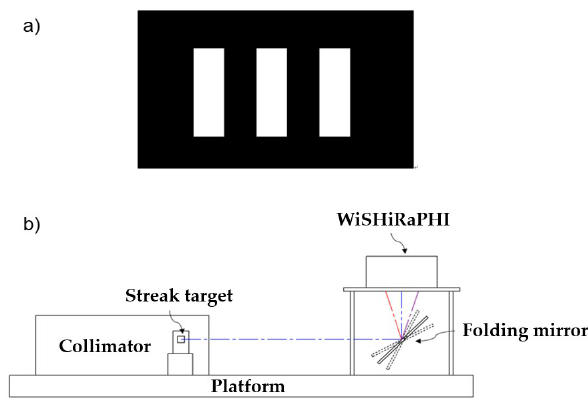
Figure 11. Sketch map of the streak target and MTF calibration system. ( a ) Shows the streak target and ( b ) shows the calibration system. Sensors 2019 , 19 , x FOR PEER REVIEW